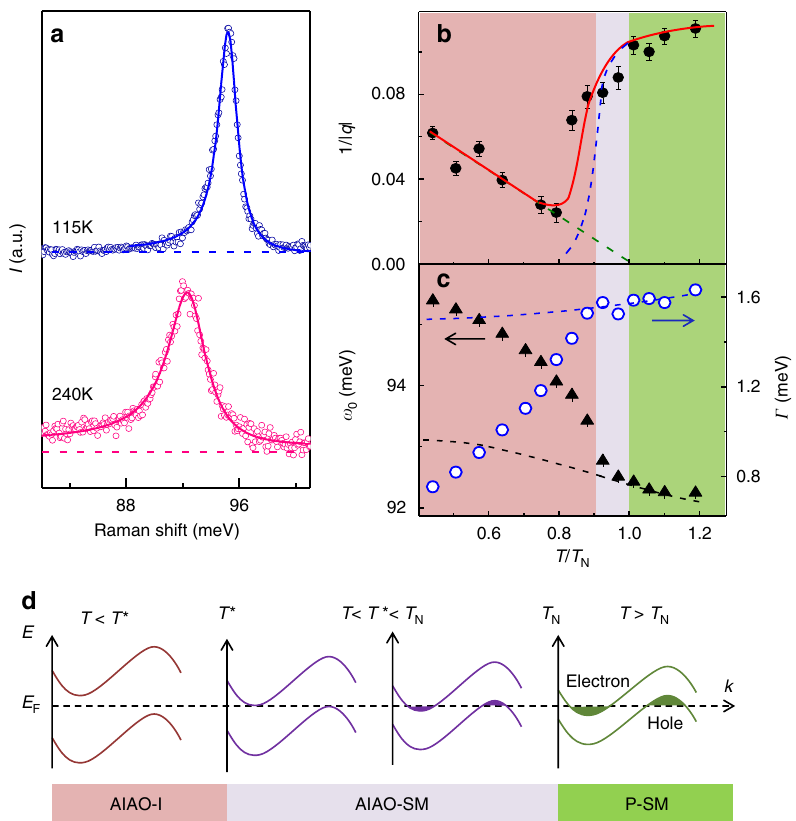
Fig. 4 The anomalous lineshape and T- dependence of the T 2g (4) phonon mode. a Raman spectra of the T 2g (4) phonon mode taken at low (115 K) and high (240 K) temperature. The data ( open pink and blue circles ) show the Raman phonon peaks and are fi tted with the Breit-Wigner-Fano function ( pink and blue solid lines ). The dashed lines indicate the frequency-independent background. b The T -dependence of the Fano asymmetry parameter. The experimental data are plotted as black circles . The solid and the dashed lines are guides for the eye. The dashed lines express the contribution of magnetic ( green dashed line ) and charge ( blue dashed line ) coupling to 1/ | q | , while the red solid line represents the total. c The frequency ( ω 0 -black triangles) and the width ( Γ -white circles) at various temperatures. The fi tted anharmonic decay model is shown in dotted lines . Error bars in b , c represent the standard deviation in the data fi tting procedure. d A schematic of the Liftshitz-type MIT, which present simpli fi ed band structures expected for the paramagnetic semimetal ( P-SM ), AIAO ordered semimetal ( AIAO-SM ), and AIAO ordered insulating ( AIAO-I ) states. Above T N , the system is a P-SM with the same number of electrons and holes due to the even number of electrons in the unit cell. The fi lled green and violet regions represent the electron and hole pockets. The electron and hole bands overlap in energy, resulting in a semimetallic state. When T decreases through T N , the emergence of AIAO ordering shifts the electron and hole bands upwards and downwards respectively, gradually annihilating the Fermi surface. With a further decrease in T , the electron and hole pockets disappear and their overlap in energy eventually becomes zero at T* . Below T* , a true energy gap develops between the electron and hole bands, resulting in a